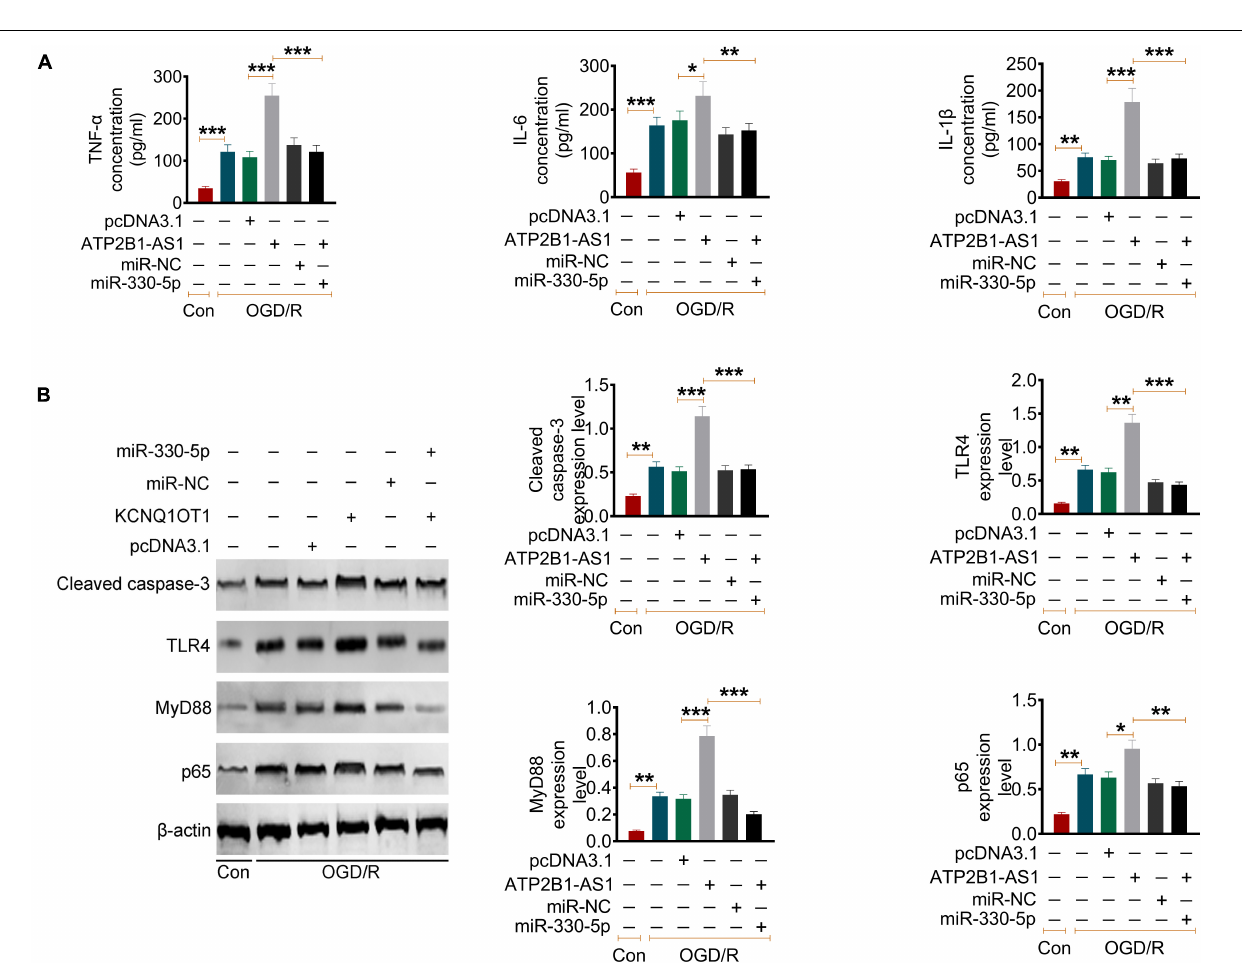
FIGURE 7 | Effect of ATP2B1-AS1 and miR-330-5p on cytokines and the TLR4-MyD88-NF- κ B signaling pathway in OGD/R PC12 cells. (A) The effect of pcDNA3.1-ATP2B1-AS1 and miR-330-5p mimics on the cytokines levels in OGD/R PC12 cells. PcDNA3.1-ATP2B1-AS1 reduced the level of TNF- α , IL-1 β , and IL-6 of OGD/R PC12 cells. These effects of ATP2B1-AS1 on the OGD/R PC12 cells were abrogated by miR-330-5p mimics. (B) The effect of pcDNA3.1-ATP2B1-AS1 and miR-330-5p mimics on the expressions of cleaved Caspase 3, TLR4, MyD88, and NF- κ B p65 in OGD/R PC12 cells. PcDNA3.1-ATP2B1-AS1 increased the expressions of cleaved Caspase 3, TLR4, MyD88, and NF- κ B p65, miR-330-5p mimics abrogated the increasing effect of pcDNA3.1-ATP2B1-AS1. * P < 0.05, ** P < 0.01, *** P <